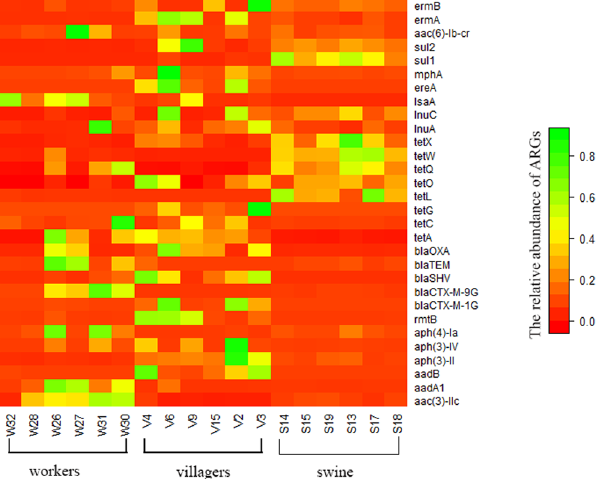
Figure 4. Relative abundances of ARGs among the swine, farm workers and local villagers. The relative abundance of each ARG ranges from absent (red) to abundant (green).